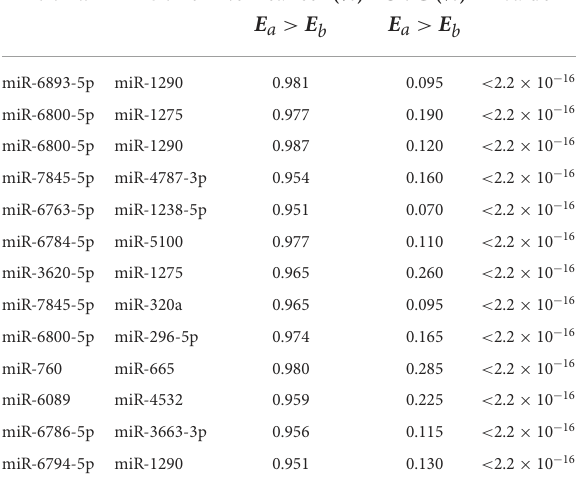
TABLE 2 The 13-miRPairs classifier developed for distinguishing OVC from non-cancer samples. miRNA a miRNA b Non-cancer